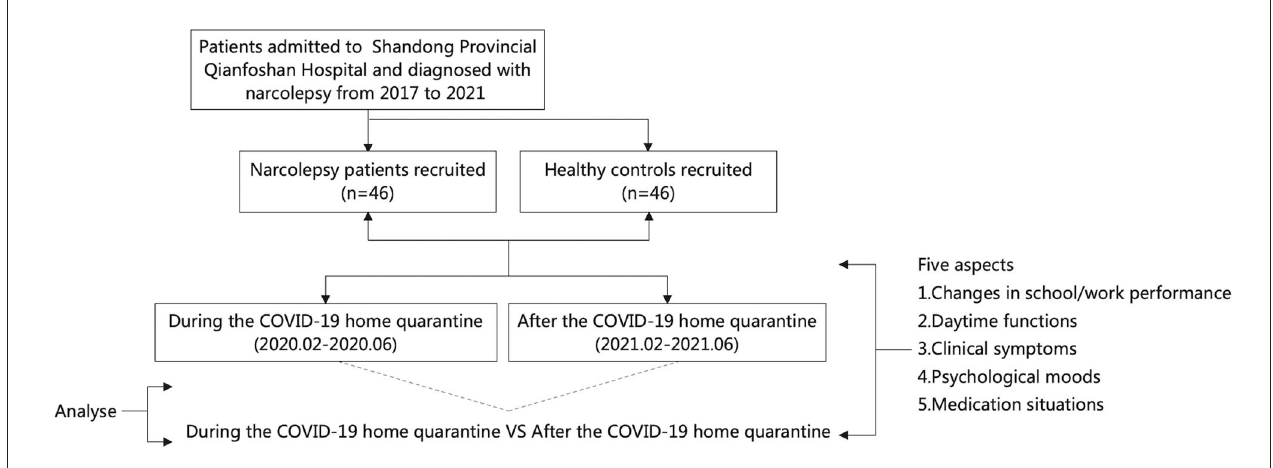
FIGURE 1 | Consort diagram and participant